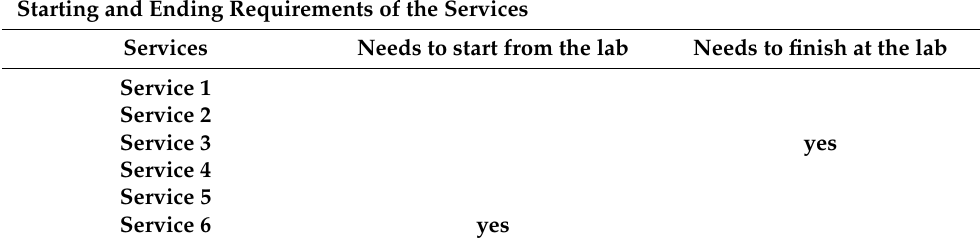
Table 4. Starting and ending features of the services.